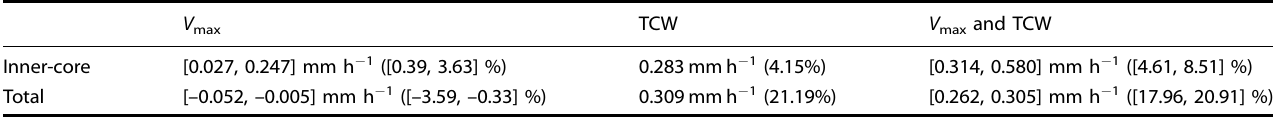
Table 2. Changes in rainfall in the inner-core (within 100 km radius) and the total area (within 500 km radius) according to the 1 – 10% increment of V max , 14% increment of TCW, and both.